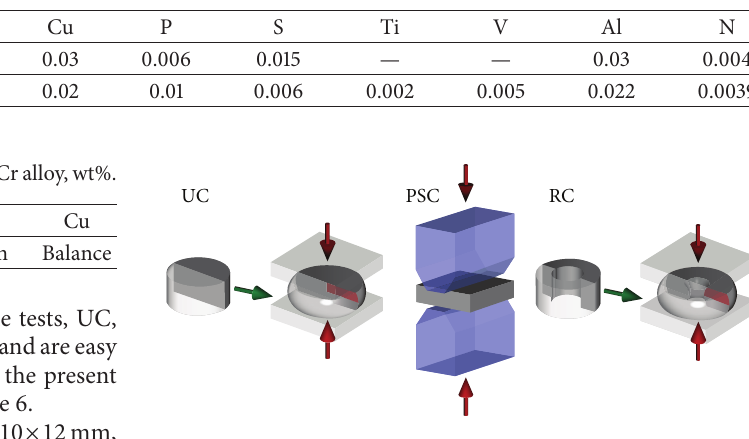
Figure 6: Schematic illustration of the compression tests investi- gated in the present